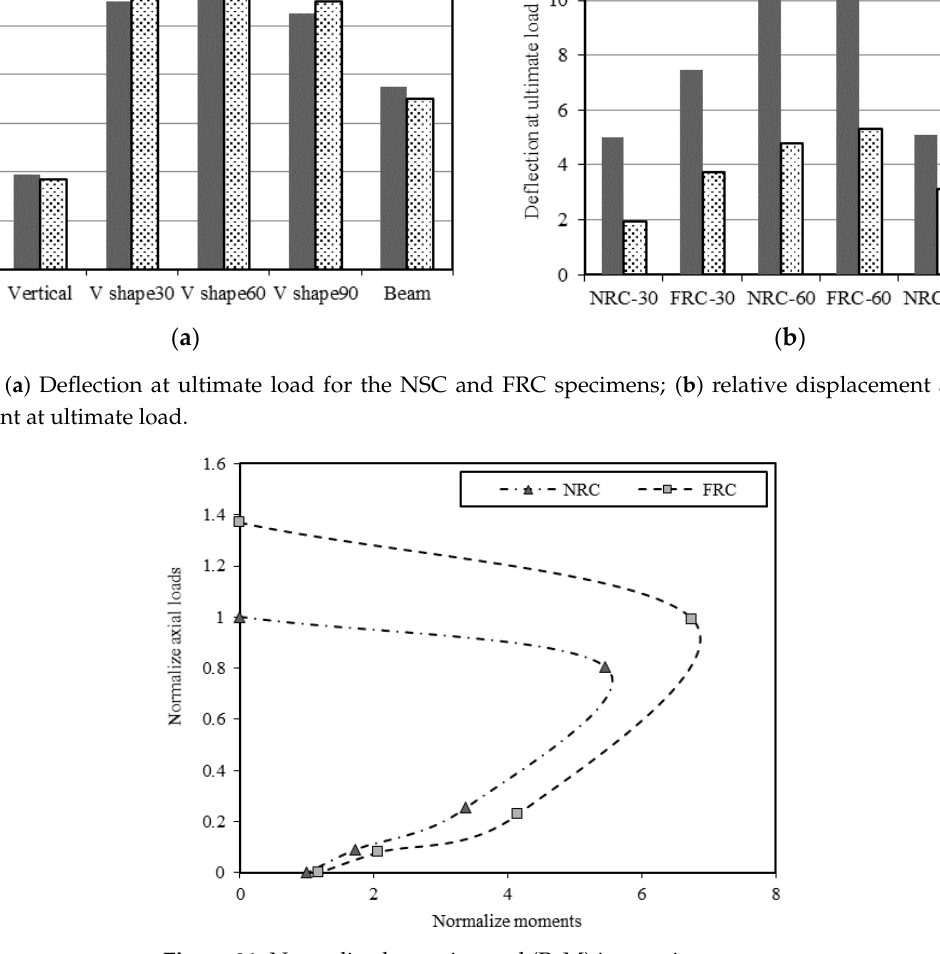
Figure 21. Normalized experimental (P – M) interaction curve.